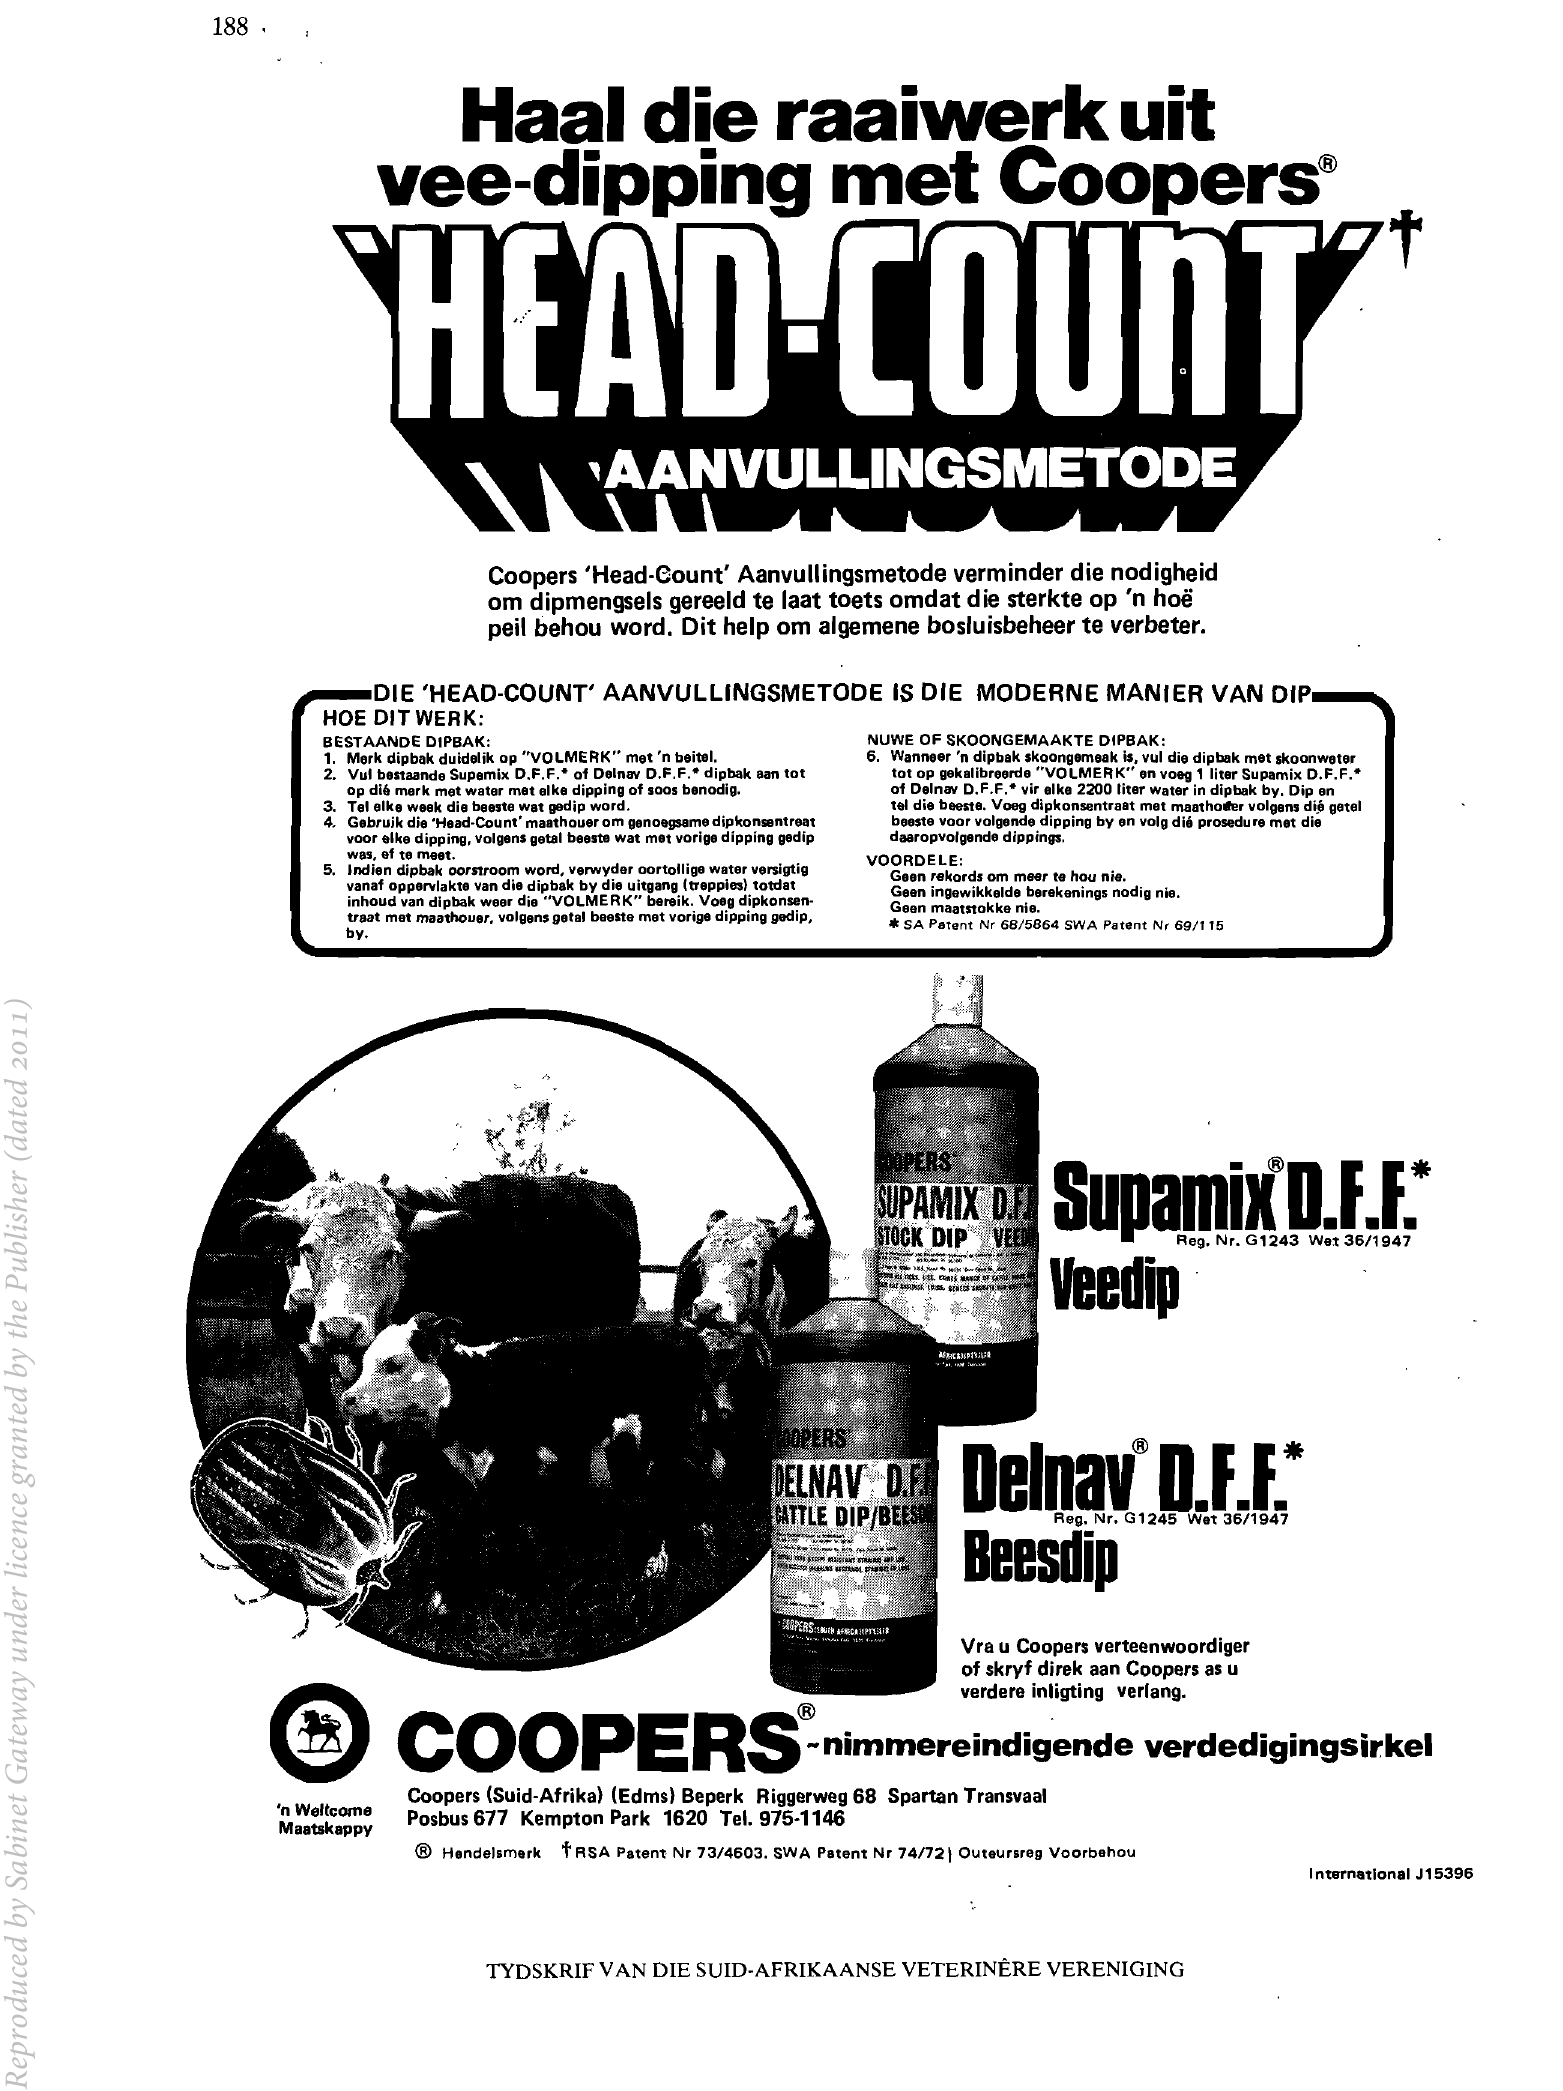
COOPERS~nimmereindig'ende